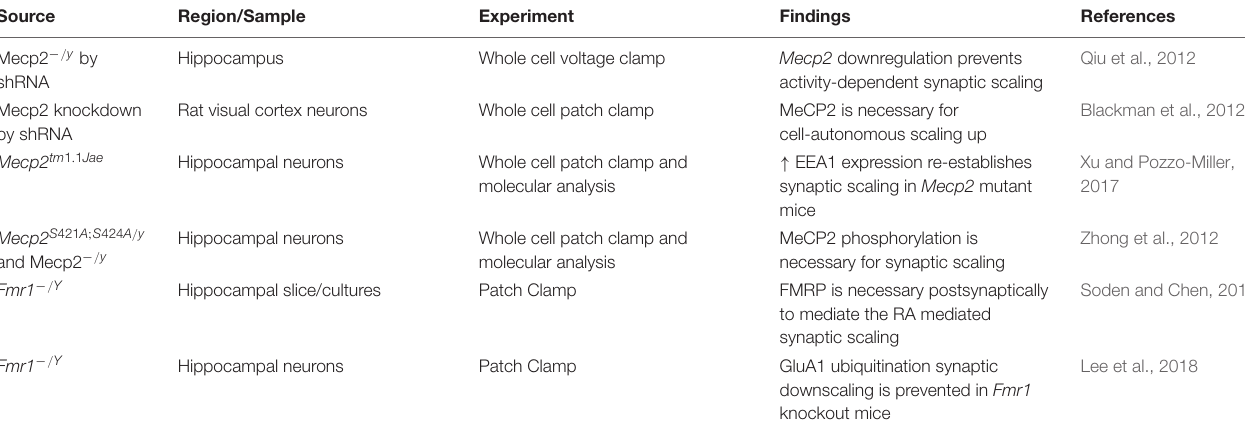
TABLE 4 | Altered homeostatic plasticity in Rett syndrome and Fragile X